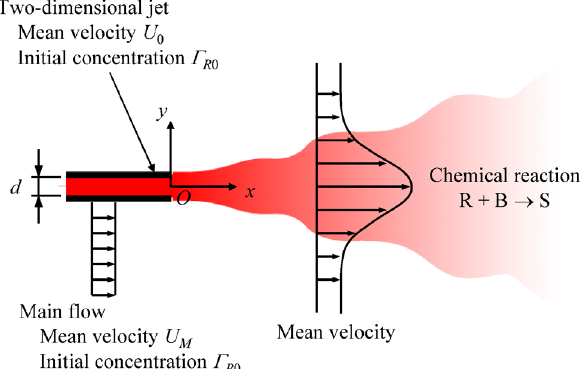
Fig. 1 Schematic of turbulent reactive plane